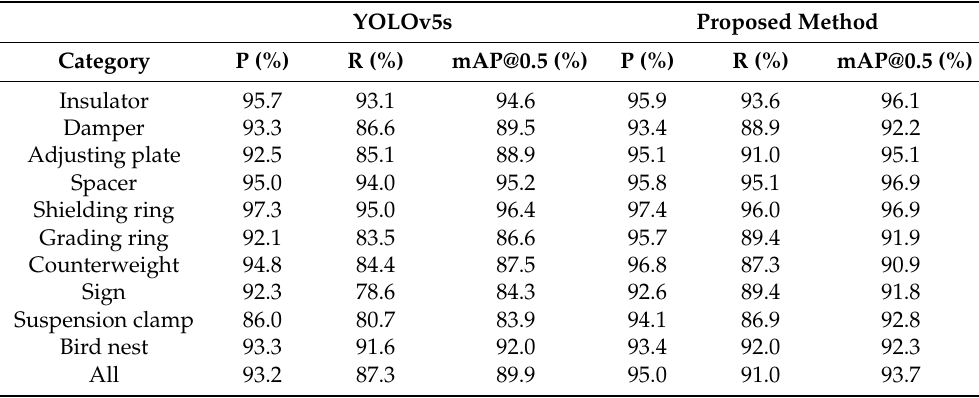
Table 2. Comparison of detection results in the test set.